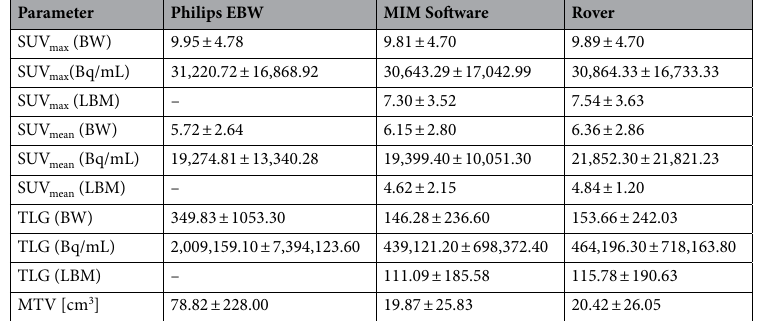
Table 5. Mean values and standard deviation (SD) for all assessed PET parameters from particular